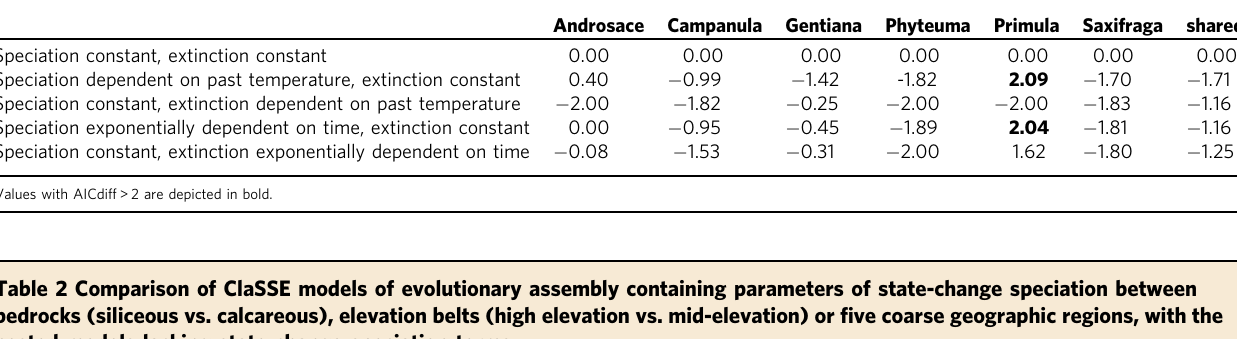
Table 1 Median AIC differences (AICdiff) between multiple time- or temperature-dependent diversi fi cation models and the nested null model with constant speciation and constant extinction.